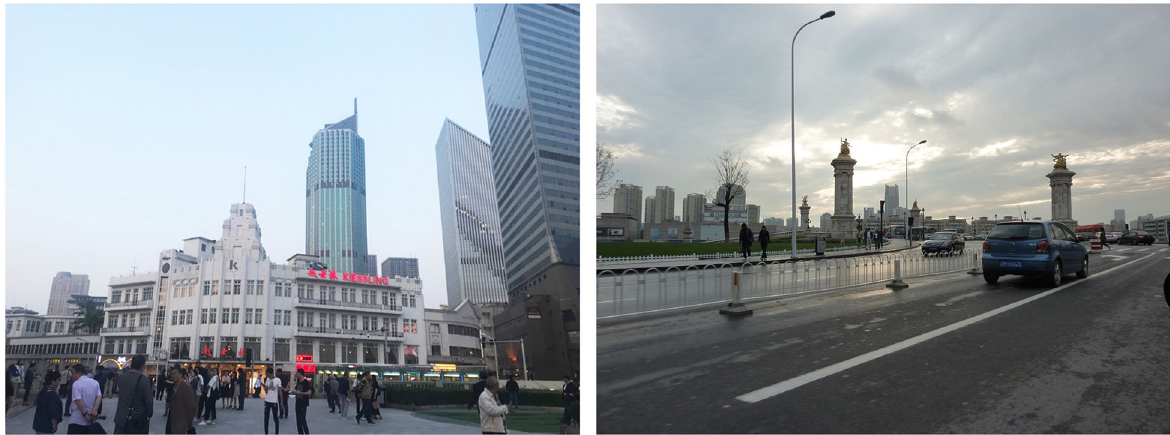
Fig. 5 Left: modern and historic buildings in former foreign concessions in Tianjin (Source: Yue Lu, 2018). Right: a recent ‘ copy ’ of the Alexandre III Bridge in Paris (Source: Bruno Chauffert-Yvart, 2018)